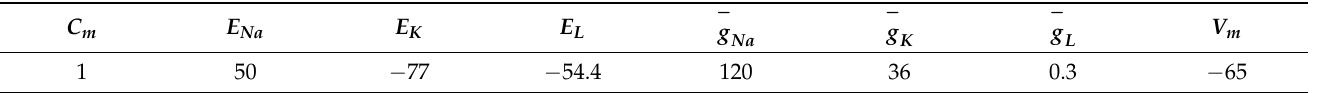
Table 1. The parameters of the model.